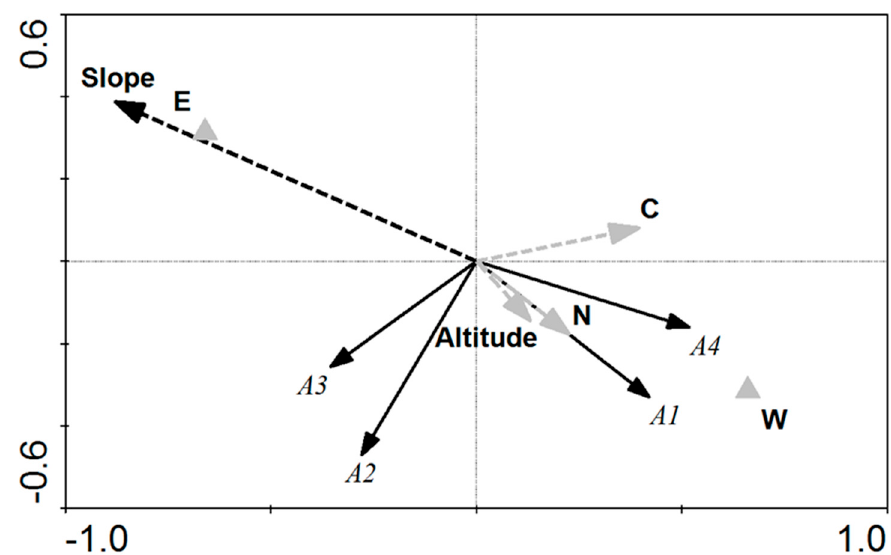
Figure 3. Biplot from the pRDA showing the position of the following: (1) number of acorns each year (solid arrows), (2) significant (dashed black arrows) and not significant (dashed grey arrows) topography variables. Eigenvalues: axis 1 = 0.162, axis 2 = 0.105, axis 3 = 0.024. Dummy variables are represented by solid black (significant) and grey (not significant) triangles. E: east, W: west, Slope: slope inclination (%), N: N soil content (%), C: C soil content (%).